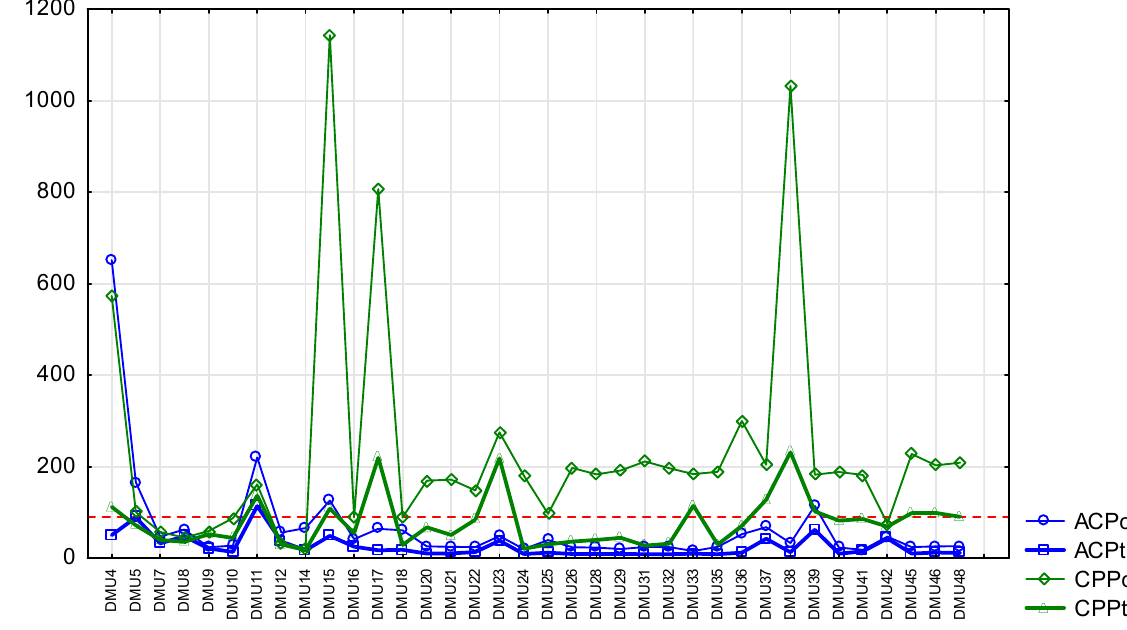
Figure 3. Comparison of current and target values of ACP and CPP (days). Legend: ACP c —current Average collection period, ACP t —target Average collection period, CPP c —current Creditors payment period, CPP t —target Creditors payment period.